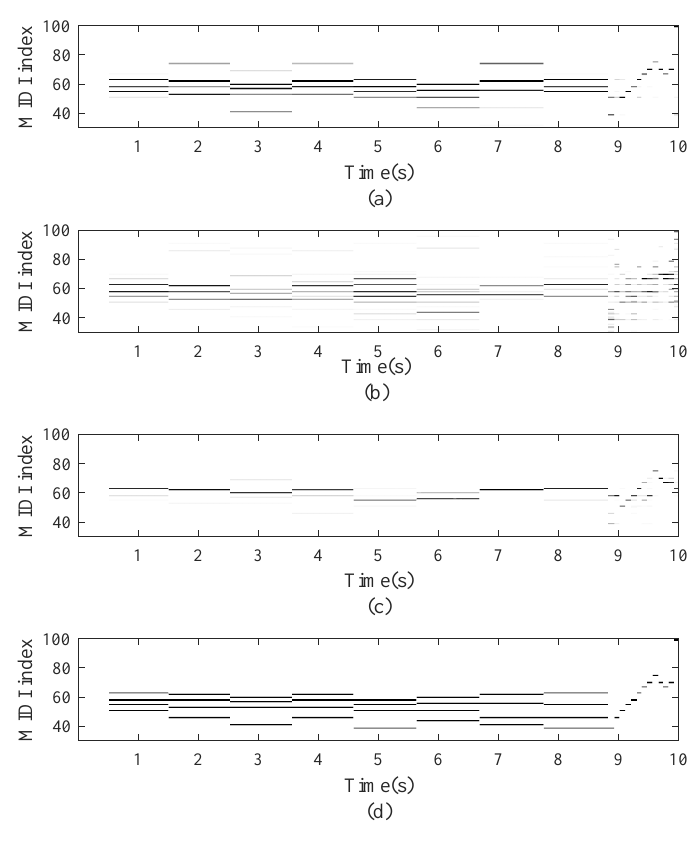
Figure 7. Results of multi-pitch estimation (MPE): ( a – c ) the output of CNN, DNN, and RNN, respectively; ( d ) the corresponding ground truth piano roll